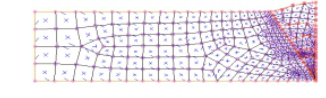
Figure 1. Two-dimensional grid model